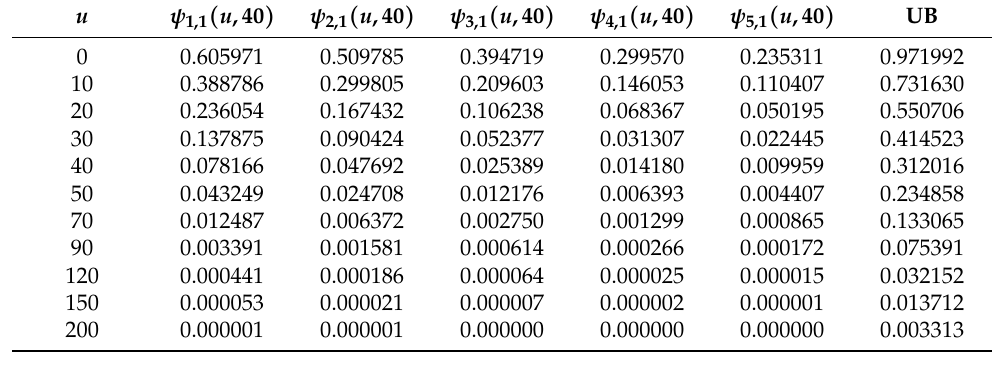
Table 7. ψ i ,1 ( u ,40 ) values with upper bounds (UB).